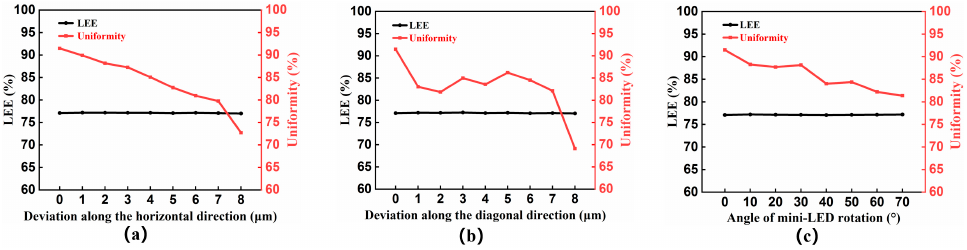
Figure 8. Relationships between the different deviations of the mini-LED center off the cone-shaped light coupling microstructure and the LEE and uniformity: ( a ) Deviation along the horizontal direction, ( b ) deviation along the diagonal direction, and ( c ) mini-LED rotation.